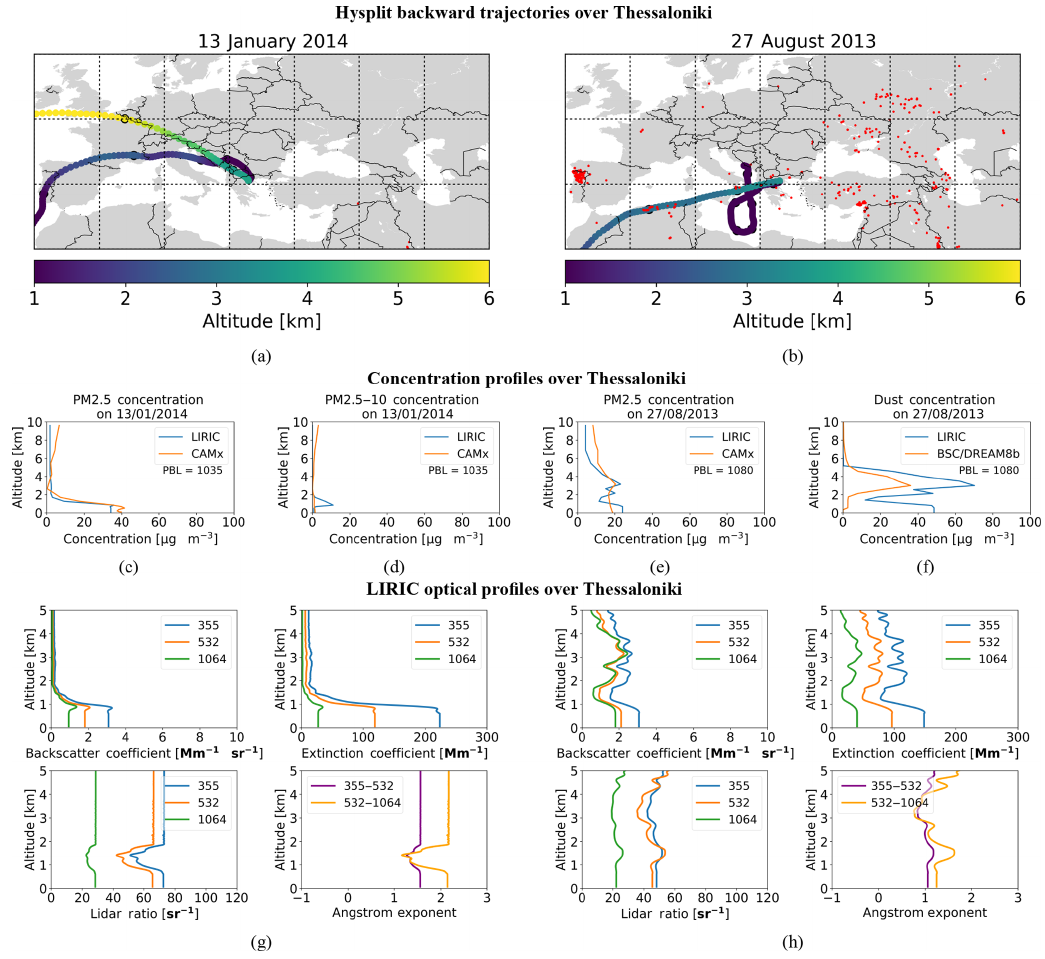
Figure 3. Two sample cases are presented here. The left column corresponds to a continental aerosol case on 13 January 2014, while the right column corresponds to a dust aerosol case on 27 August 2013. The wind back-trajectories (a, b) , the PM 2 . 5 and PM 2 . 5 − 10 concentration profiles of LIRIC (c, d, e, f) , and the respective optical products (g, h) are included. The big black dots in (a) and (b) indicate 24h